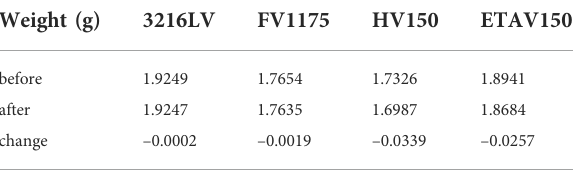
TABLE 2 Weight changes of envelope materials before and after immersing in deionized water. Weight